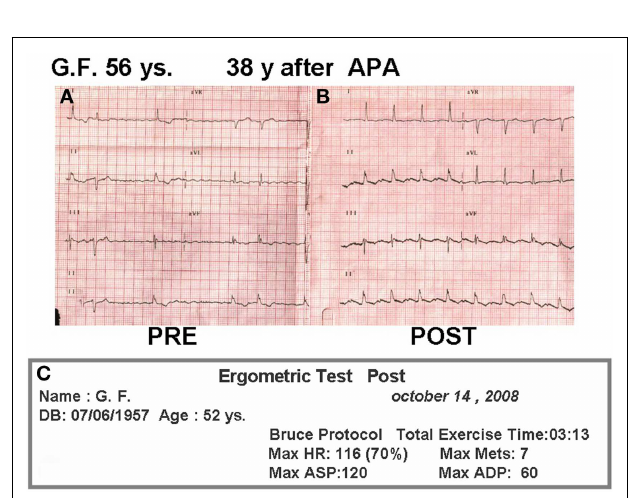
FIGURE 7 | (A) Pre-reconversion ECG. (B) ECG 2years after conversion. (C) Treadmill test 2years after conversion.